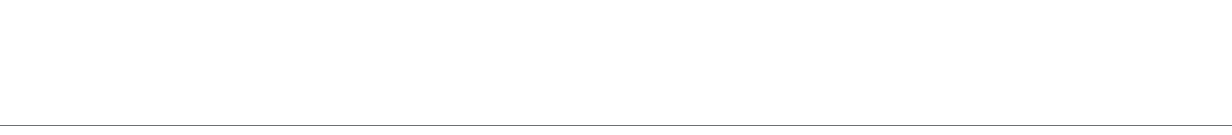
Frontiers in Genetics |